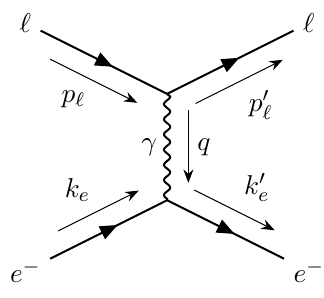
Figure 5 . ‘ scatters off e − via γ